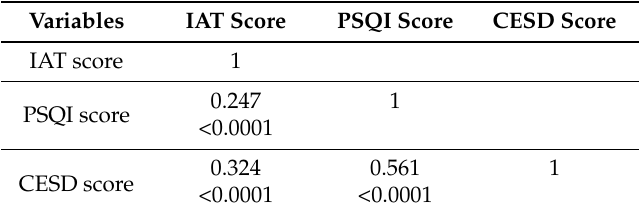
Table 2. Correlation between IAT score, PSQI score and CESD score.